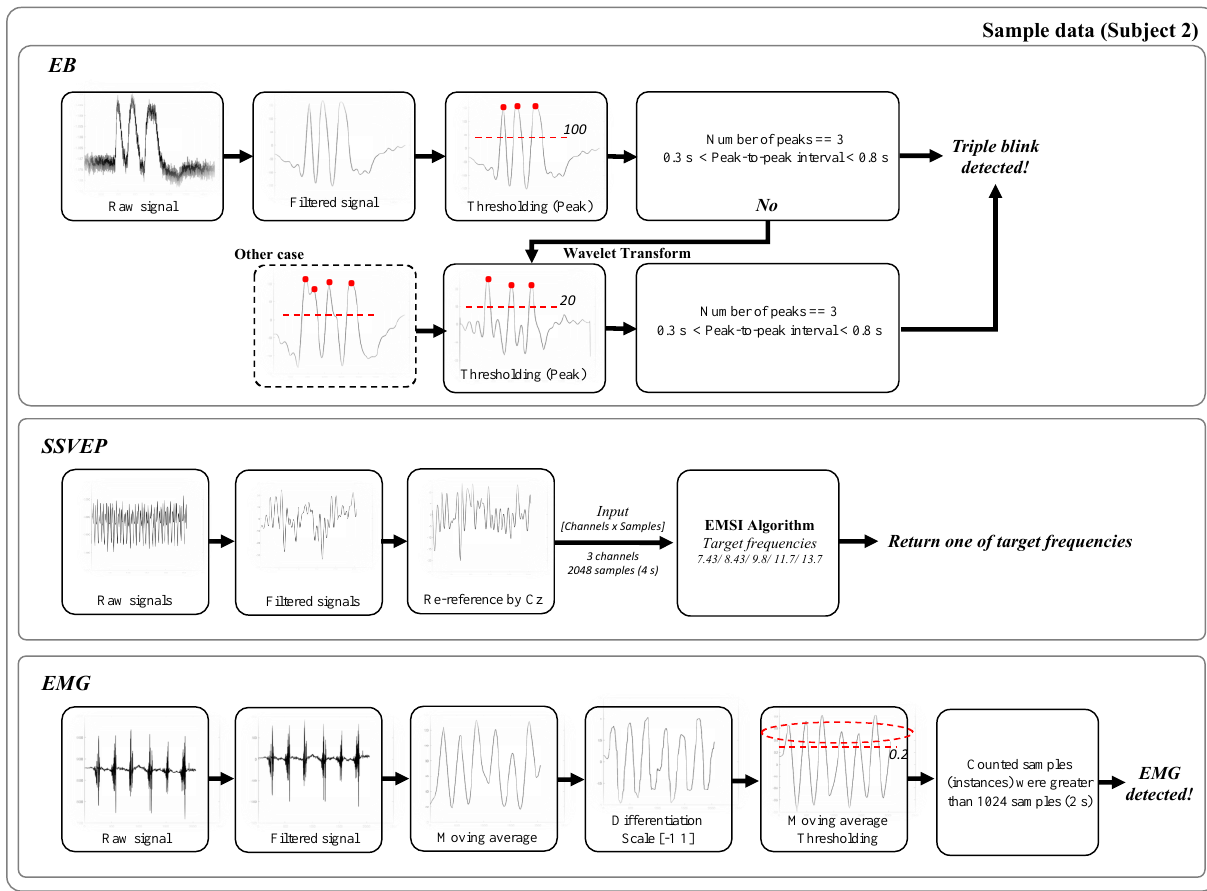
Figure 3. Procedure of processing and detection of triple eye-blink (EB), steady-state evoked potential (SSVEP), and electromyogram (EMG). Extension to multivariate synchronization index (EMSI).